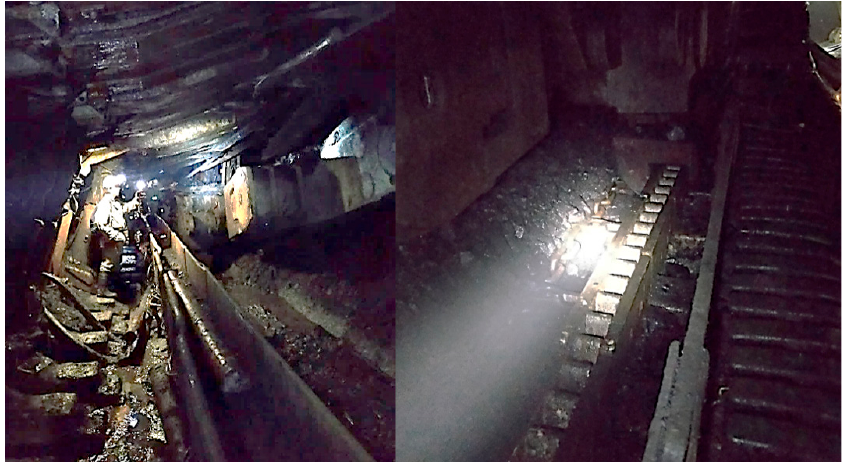
Figure 21. View of the shearer during the underground tests with the Komtrack haulage system in Piast–Ziemowit coal mine.